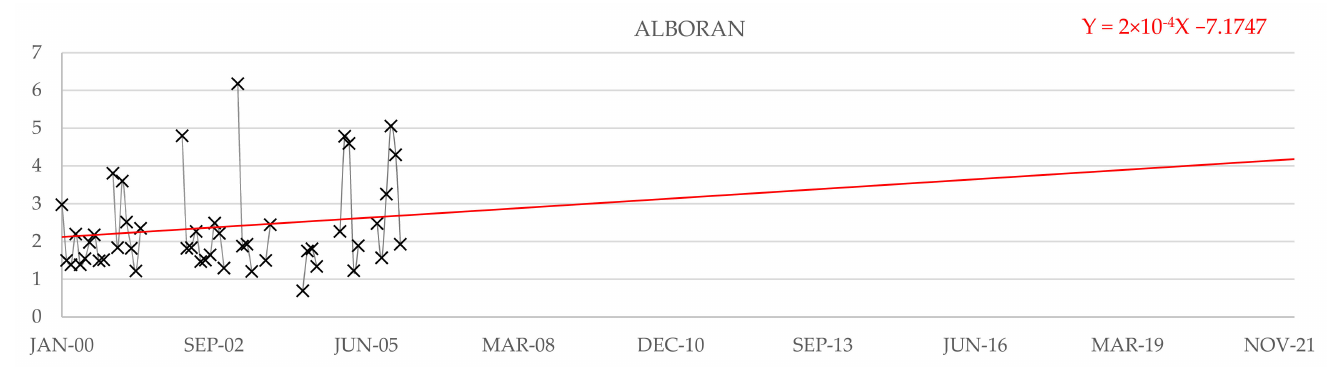
Figure 3. Evolution of Hs maxima in the Gulf of Cadiz.